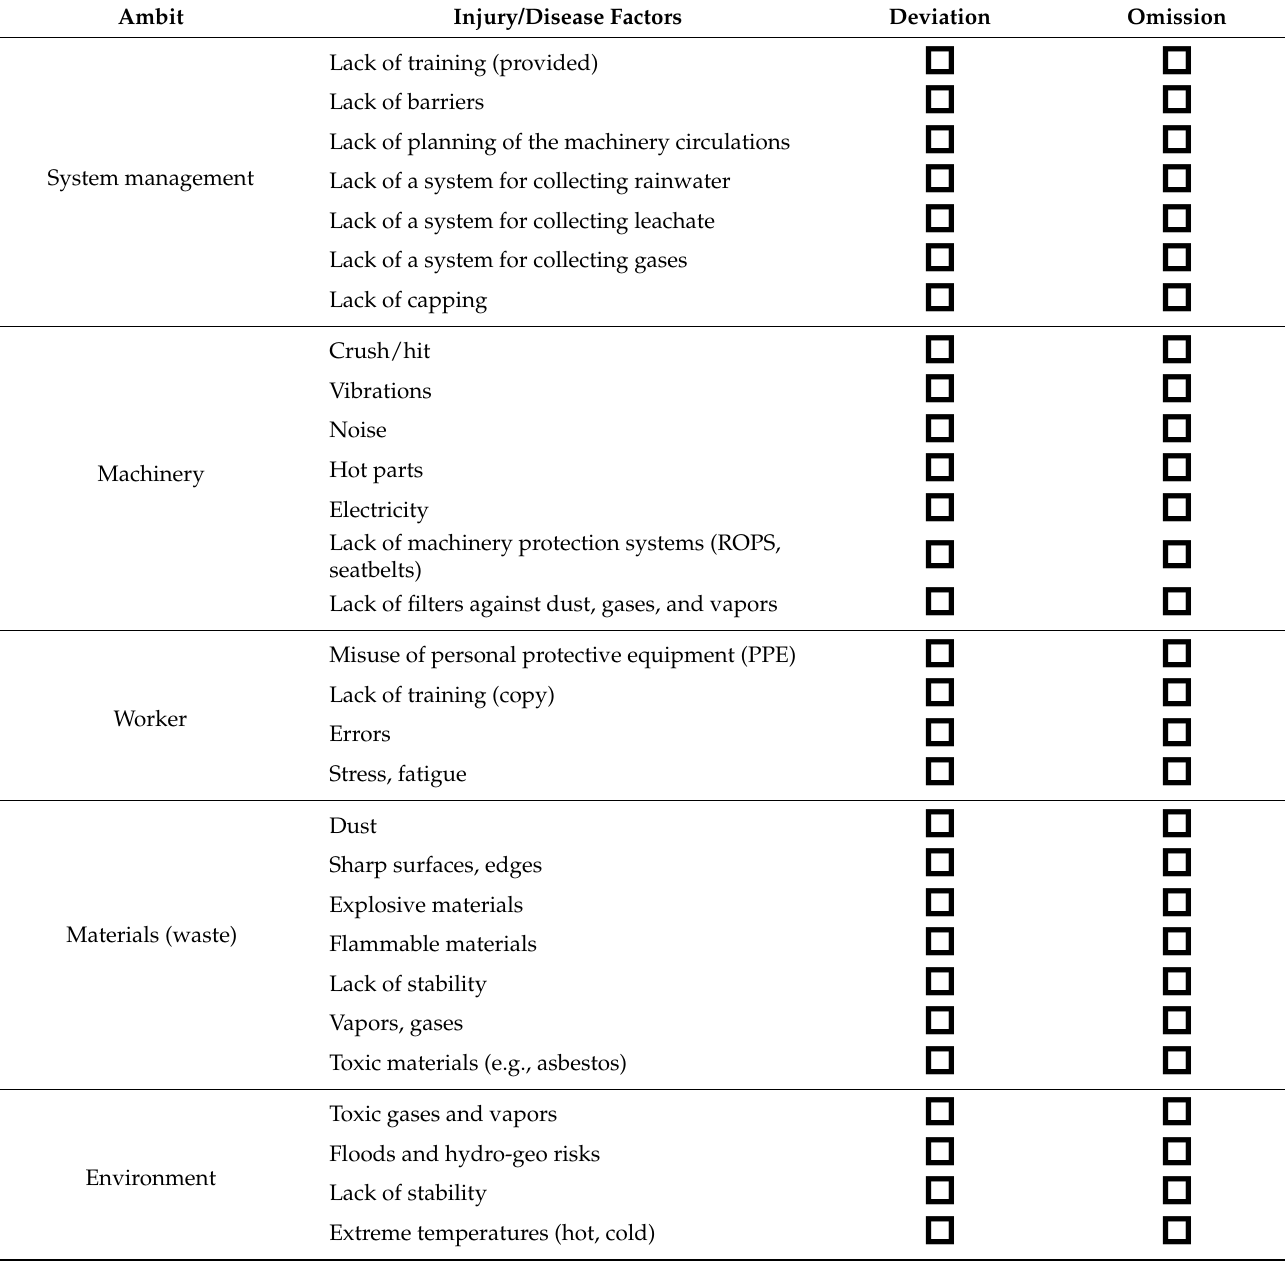
Table 11. Checklist of the main injury causes and factors in landfill